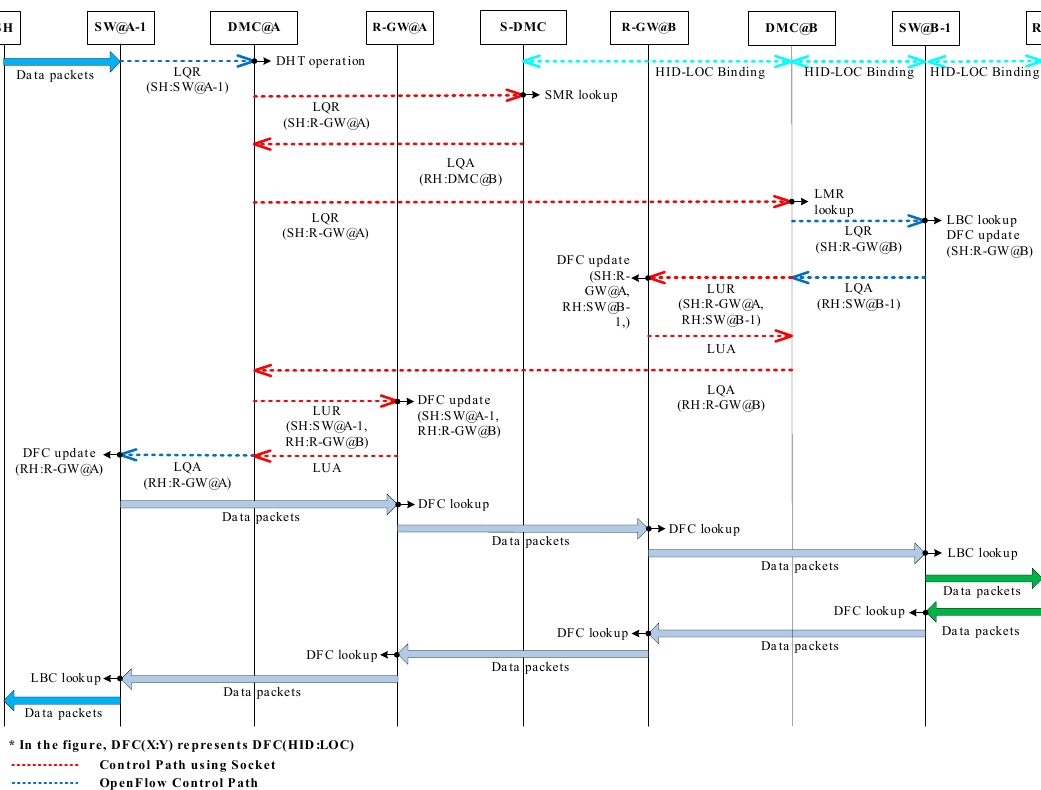
Figure 7. Inter ‐ domain LOC query operations for data delivery (case 2).